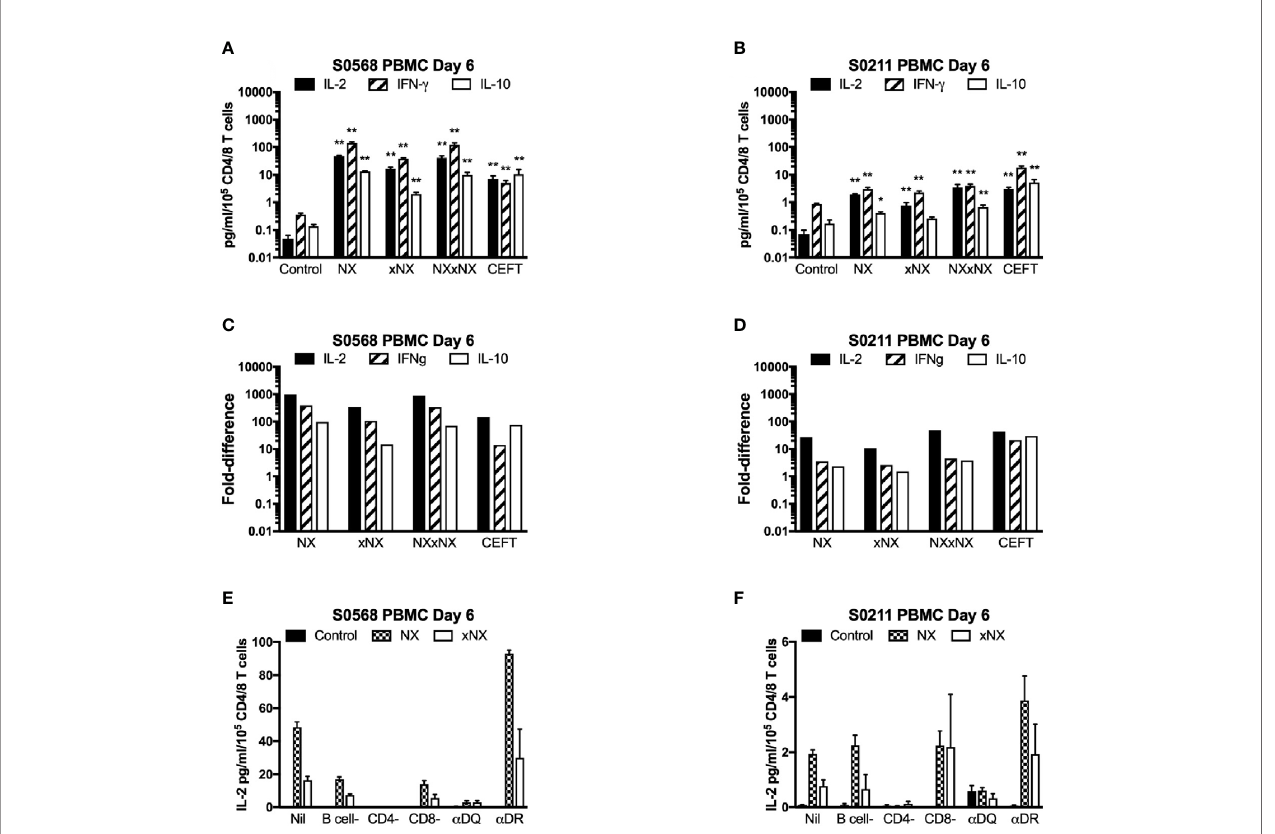
FIGURE 3 | Cytokine release in fresh PBMC from two HLA-DQ2.5+ CD patients. Concentrations (A, B) and fold-change relative to control (C, D) are shown for IL- 2, IFN- g , and IL-10 in media after 24-hour incubation of PBMC with gluten peptides or CEFT. Data are normalized for the number of live CD3+CD4+ and CD3+CD8+ T lymphocytes in PBMC and represent the mean + SEM of six replicate wells; Mann-Whitney U test was used to compare cytokine release for peptide mixes versus Control (statistical signi fi cance is indicated by *p < 0.05, or **p < 0.01). IL-2 release in PBMC is shown following depletion of B cells, CD4+ T cells or CD8+ T cells, or pre- and co-incubation with antibody that blocks epitope presentation by HLA-DQ or HLA-DR, data represent mean of duplicates (E, F)